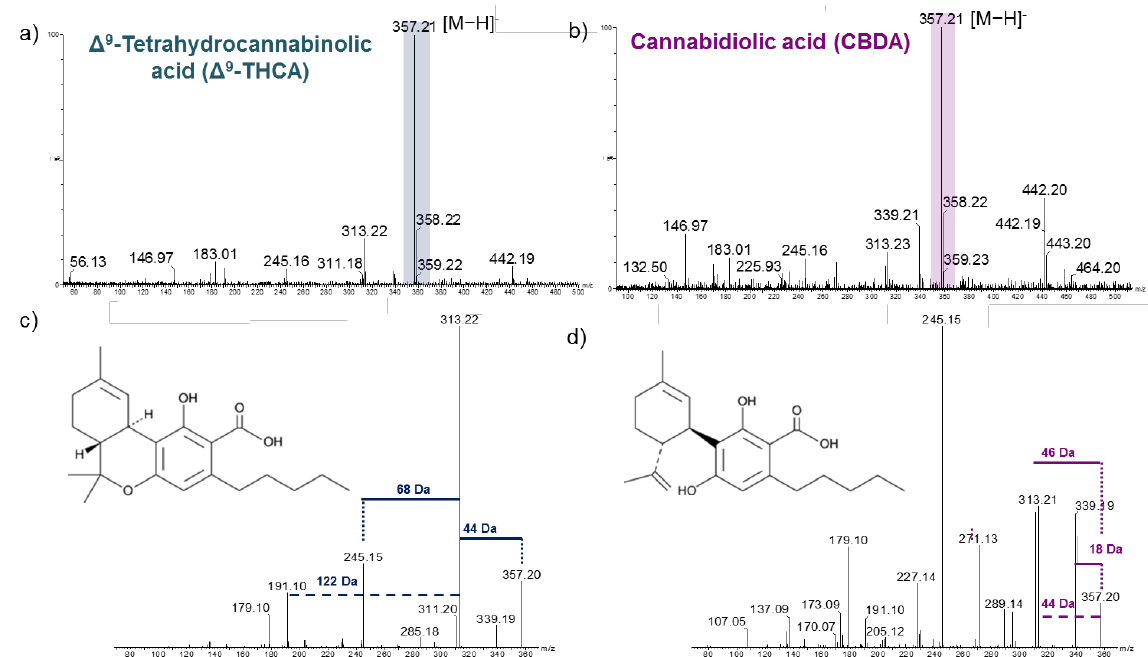
Figure 1. Cannabinoid mass and fragmentation negative ion mode spectra. ( a ) Δ 9 -tetrahydrocannabinolic acid (Δ 9 -THCA) and ( b ) cannabidiolic acid (CBDA). There is a clear molecular peak at m/z 357.2 corresponding to the [M − H] − . The fragmentation spectra of m/z 357.2 precursor ion for each cannabinoid are shown in ( c , d ).